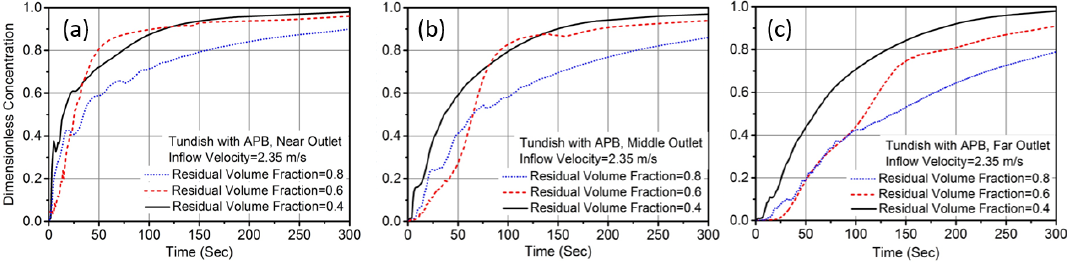
Figure 7. F-curves by varying the residual volume of reduced scale tundish with APB: ( a ) Near outlet, ( b ) middle outlet, and ( c ) far outlet.